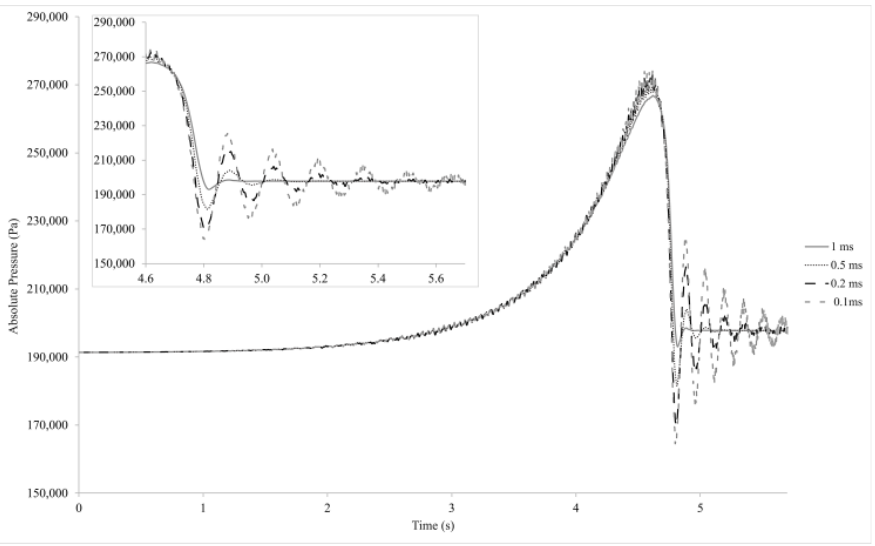
Figure 8. Average absolute pressure monitoring at section 11 m upstream of valve for four different time steps.